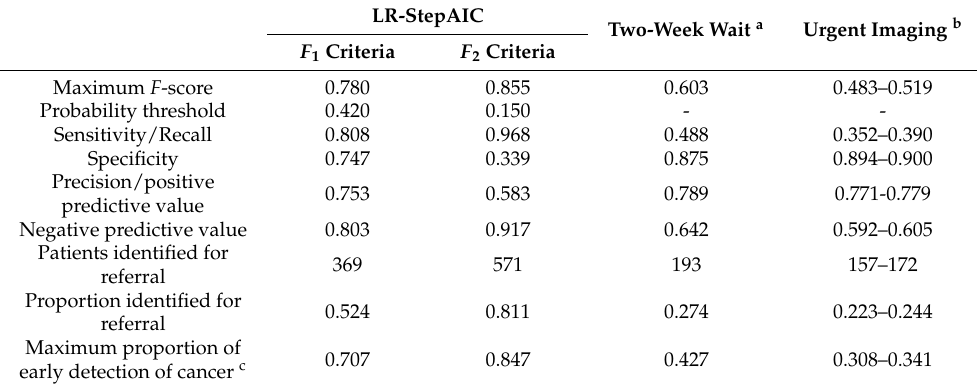
Table 3. Performance measures of the final model with different evaluation criteria (maximum F 1 and F 2 -score) and comparison with NICE referral guidelines for suspected pancreatic cancer ( n =